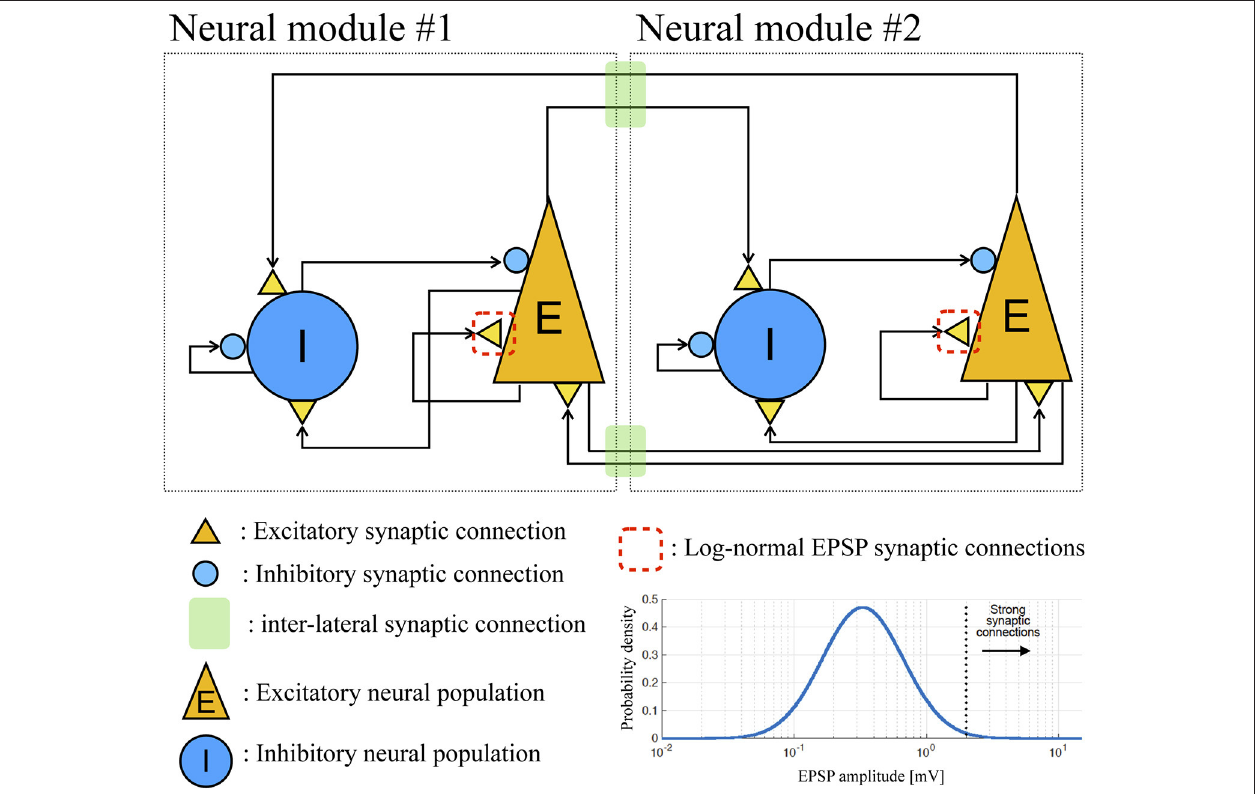
FIGURE 1 | Spiking neural network composed of two neural modules where each module is composed of the excitatory neural population with log-normal EPSP, and inhibitory neural population as the local cortical network and the two modules are joined by inter-lateral excitatory synaptic connections [ 32]. In the two coupled neural modules, under the condition of moderate input stimulus and log-normal EPSP distribution in intermodule synaptic connections, neural behavior with wide frequency components appears, especially involving a slow frequency component ( . 5 Hz). This slow neural behavior is produced from an intermittent intermodule-alternative behavior where either neural activity becomes larger (called the activated state) than the other one (deactivated state), and its alternation duration follows a gamma distribution with long-tailed